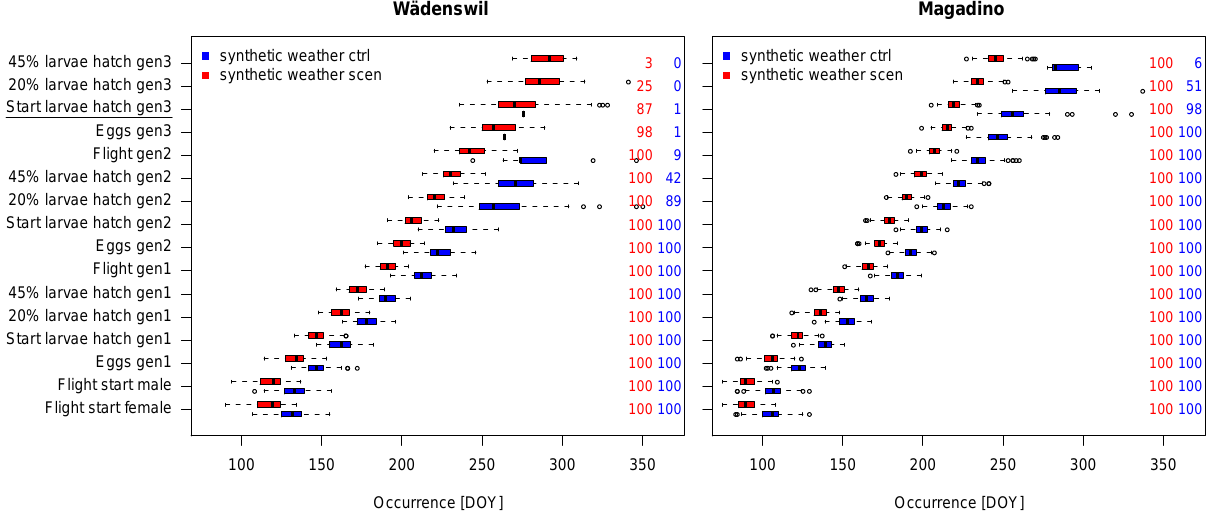
Fig. 5. Occurrences of important codling moth life phases for present (“ctrl”, blue) and future (“scen”, red, median signal of the multi- model projections) climate at the stations W¨adenswil (left panel) and Magadino (right panel). The y-axes display the life phases for three generations (denoted “gen1–3”) over one year (see Sect. 2.3.1), starting with the flight start in spring (corresponding to Fig. 4, but separately for male and female adults). The boxplots were derived from synthetic weather data representing 100yr in the present and future climate. The numbers on the right of the panels denote the percentage of years when the respective phase was reached based on the respective climate. The underlined phase “Start larvae hatch gen3” was used for the assessment of the potential risk of a 3rd codling moth generation.